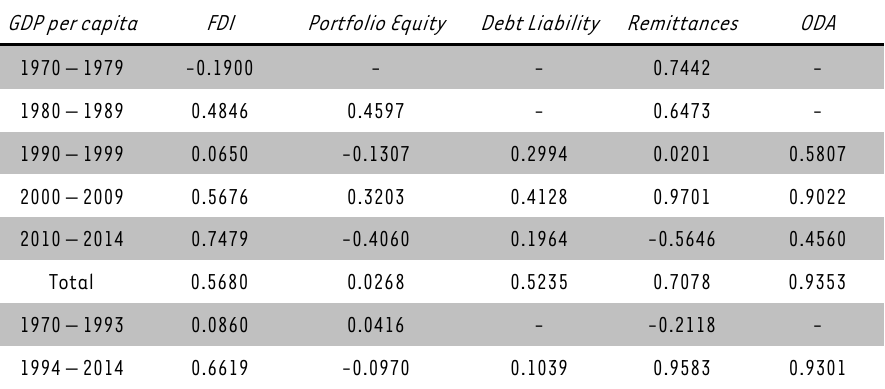
TABLE 2: Correlation of foreign capital flows and GDP per capita from 1970 – 2014 in SA GDP per capita